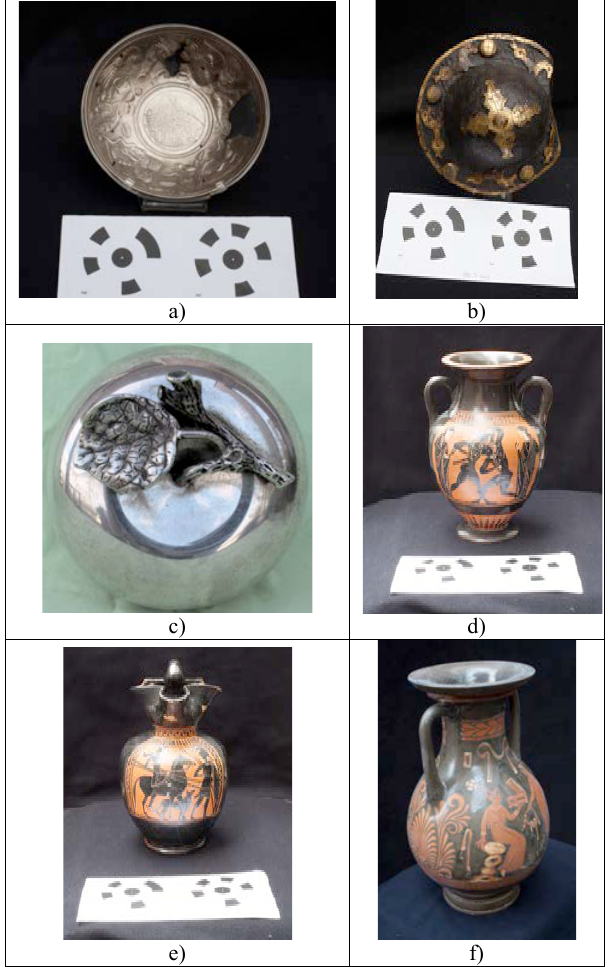
Figure 3. Metallic and ceramic test objects used in the experiments: a) Patera del Pescatore (metal); b) Lombard Umbo (metal); c) Apple box (metal), d) Greek vase (ceramic); e) Etruscan olpe (ceramic); c) dark Greek vase